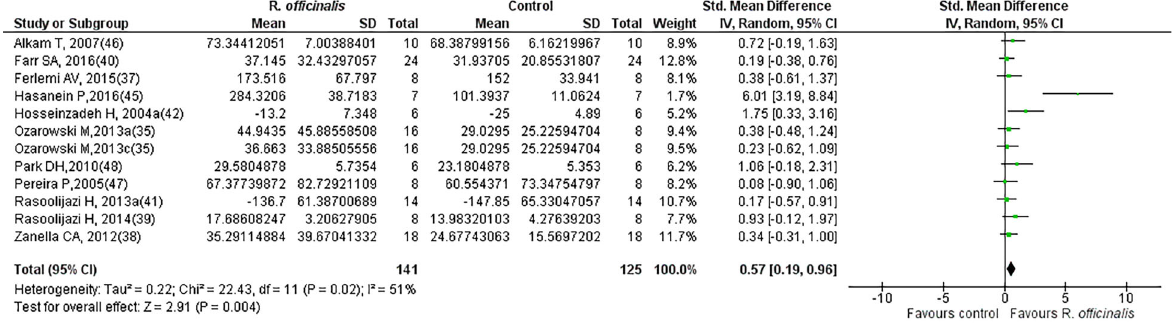
Figure 4. Forest plot of the effect of R. of fi cinalis on cognitive performance in normal animals.